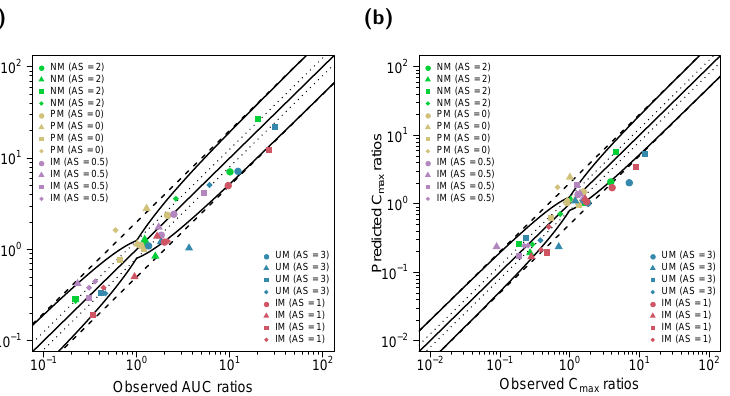
Figure 8. Predicted versus observed DD(G)I AUC last ( a ) and C max ( b ) ratios of ( E )-Clom (circles), ( E )-4-OH-Clom (triangles), ( E )-DE-Clom (squares) and ( E )-4-OH-DE-Clom (diamonds). The